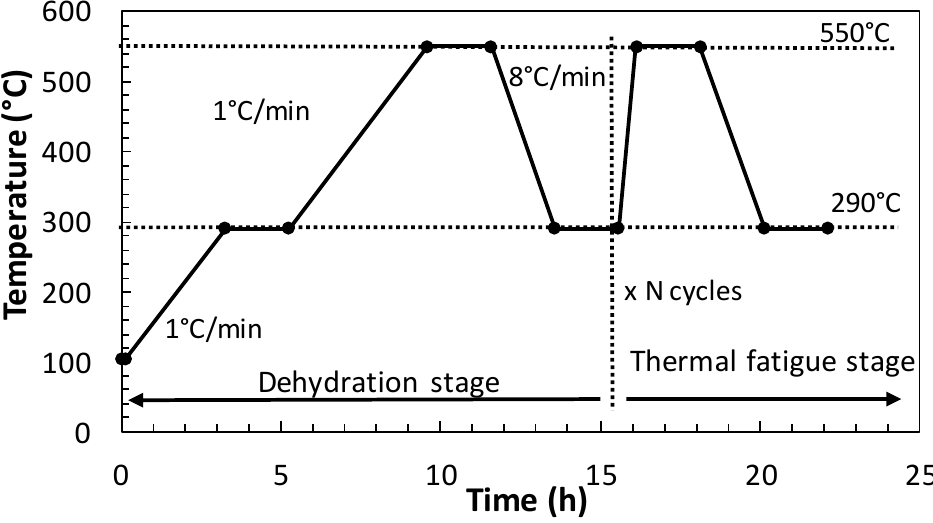
Figure 1. Heat cycle regime for thermal fatigue tests.